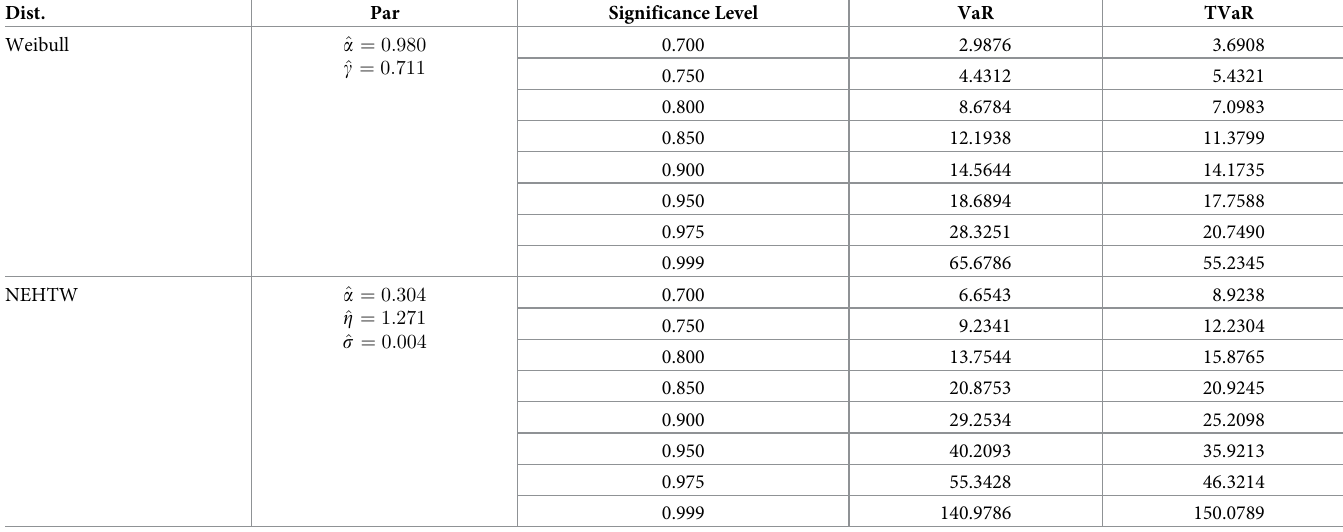
Table 14. The values of VaR and TVaR for vehicle insurance losses data.